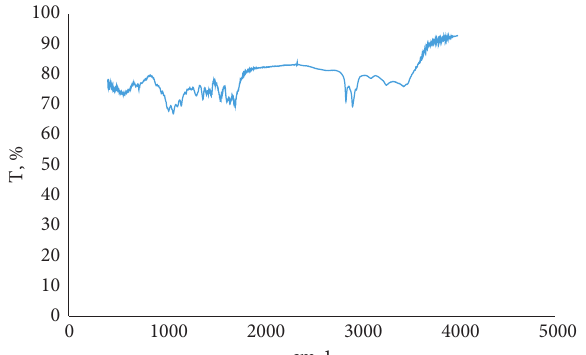
Figure 5: Infrared spectrum of low molecular weight chitosan was prepared with 6% H 2 O 2 . Table. 1: Molecular weight, viscosity, and elemental analysis of manufactured chitosan.